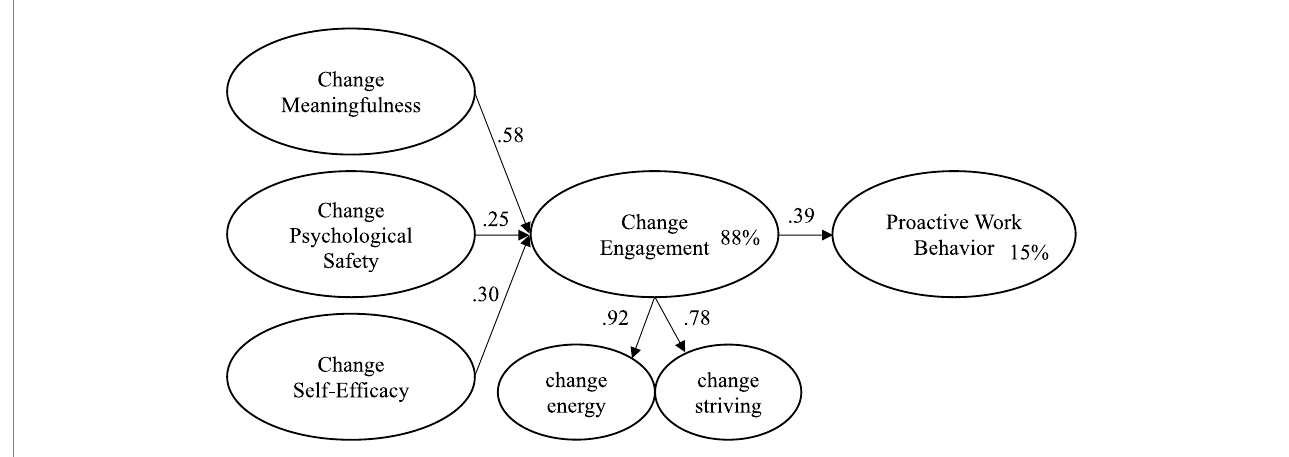
FIGURE 2 Standardized parameter estimates; percent variance explained. Items and errors not shown for ease of